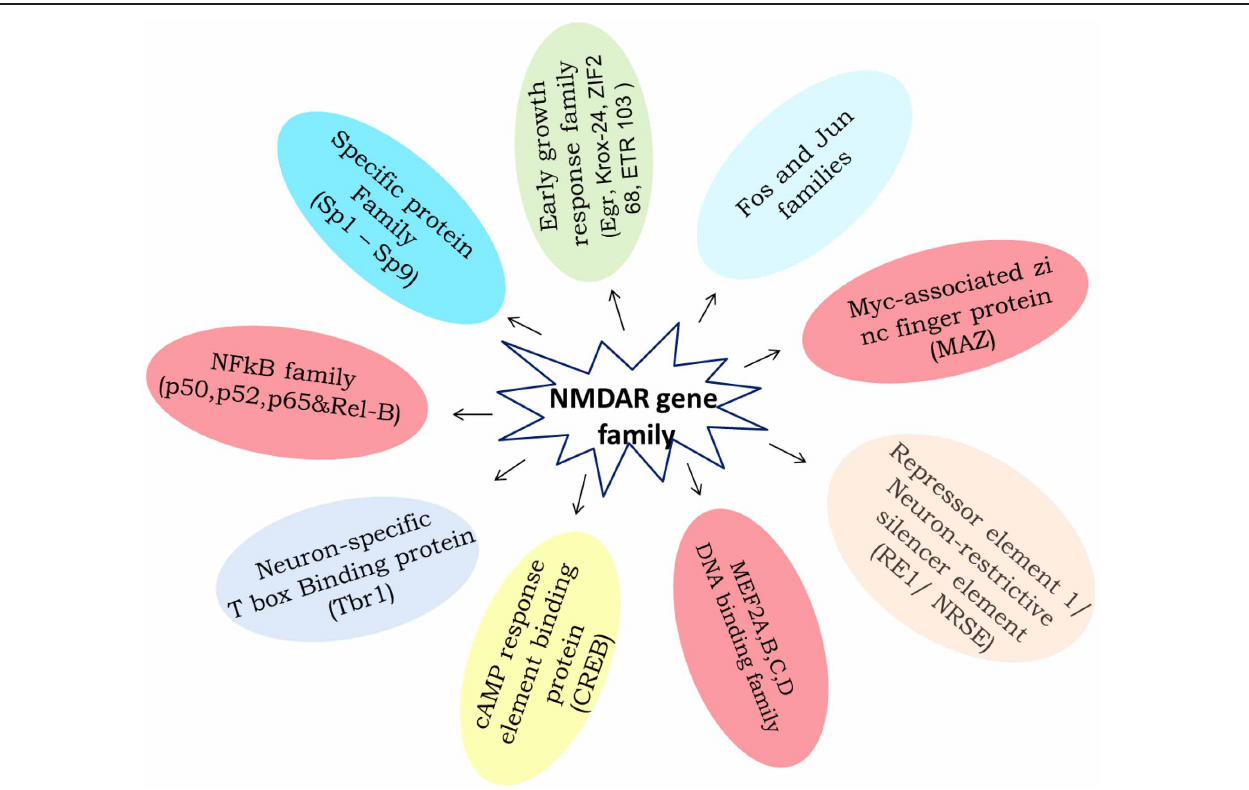
FIGURE 9 | The diagram summaries the ethanol induced to NMDA receptor subunits transcriptional regulatory binding protein family expression. Available literature characterizing the effect of chronic ethanol on transcription factors binding elements involving gene